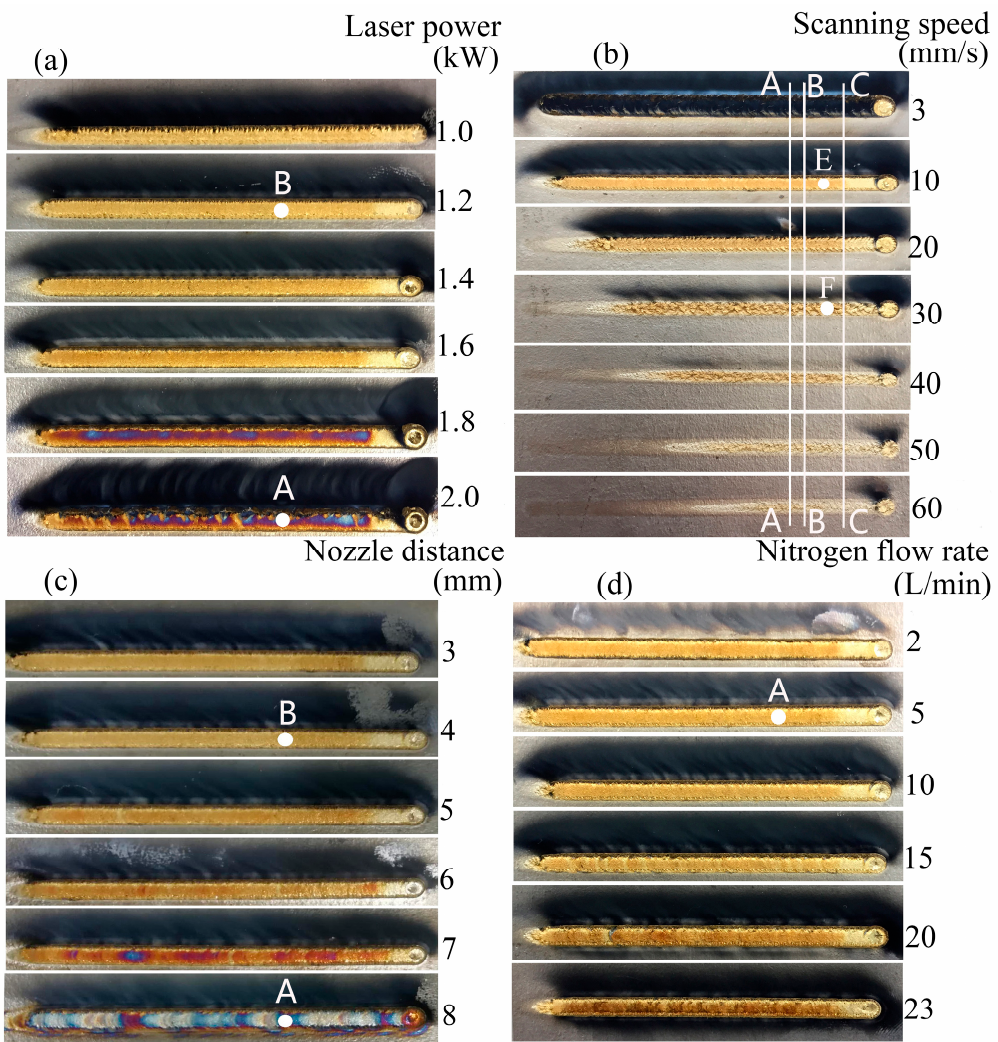
Figure 2. Top view of the nitride layer: ( a ) different powers; ( b ) different scanning speeds; ( c ) different nozzle distances; and ( d ) different nitrogen flow rates.